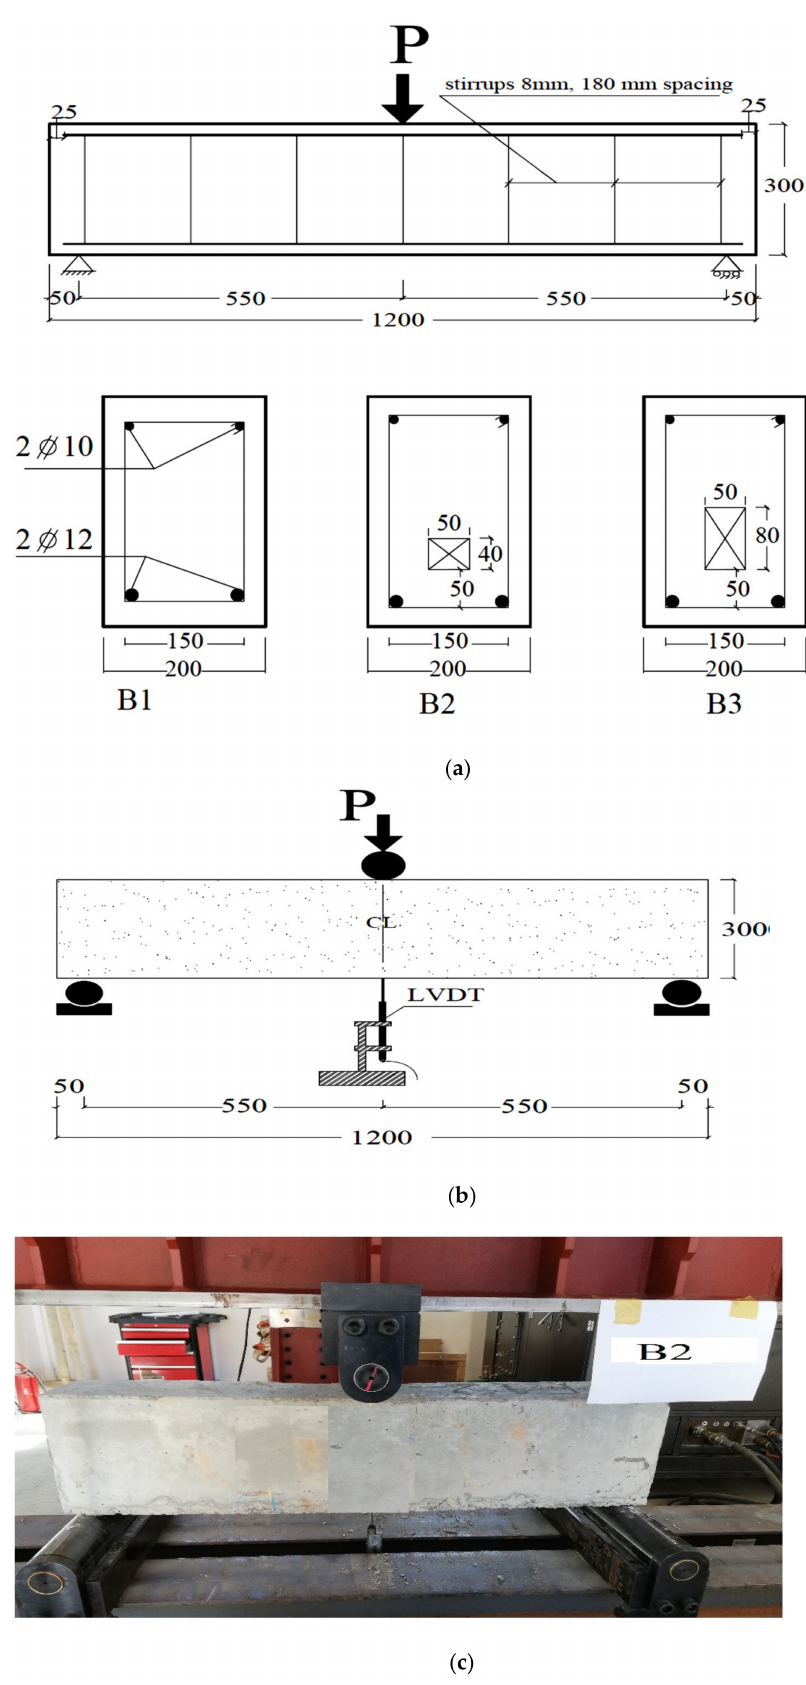
Figure 1. Specimens details and set up ( a ) dimensions and reinforcement, ( b ) test setup and instru- mentation, and ( c ) photo of set-up and instrumentation (dimensions in